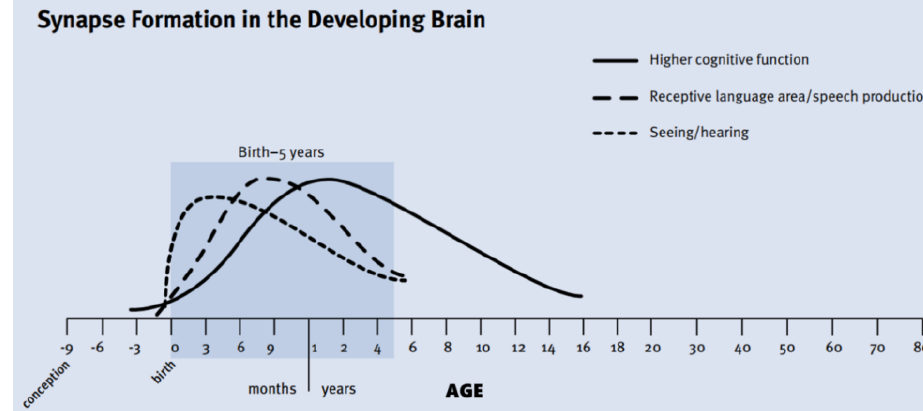
Figure 1. Synapse Formation in the Developing